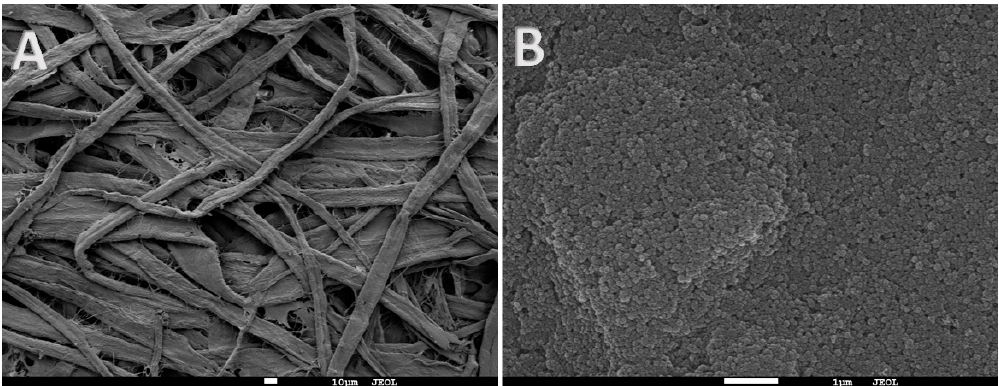
Figure 2. SEM micrographs of ( A ) unmodified paper (at 300 magnifications) and ( B ) coated paper (at 13,000× magnification). The presence of the SWNHs suprastructure, which completely covers the cellulose fibers, is observable on the surface.